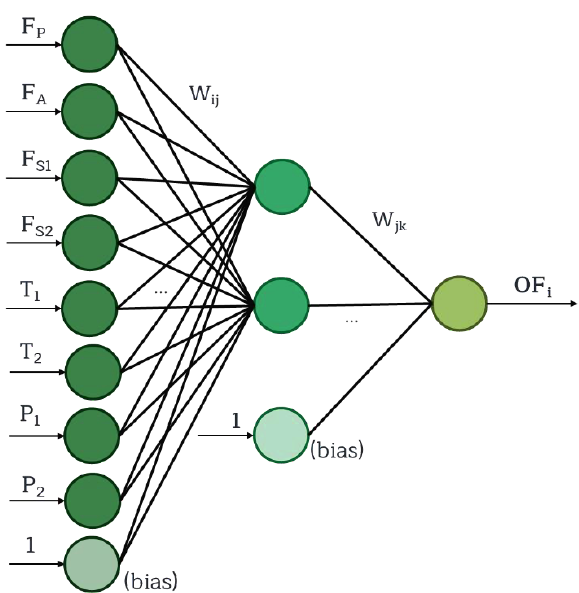
Figure 4. Three layer feedforward artificial neural network for the acrylic acid MOO problem.